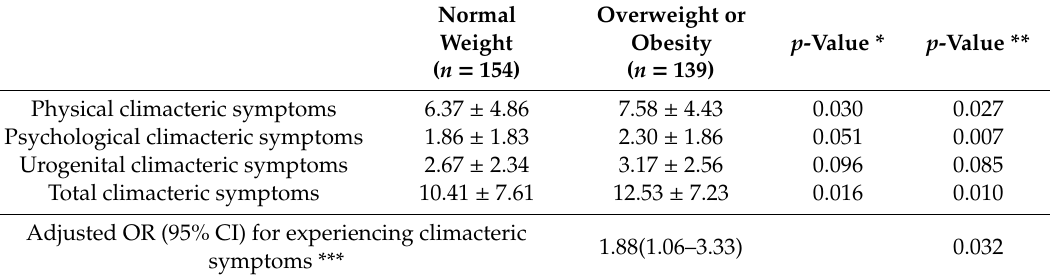
Table 2. Climacteric symptoms according to body mass index categories.